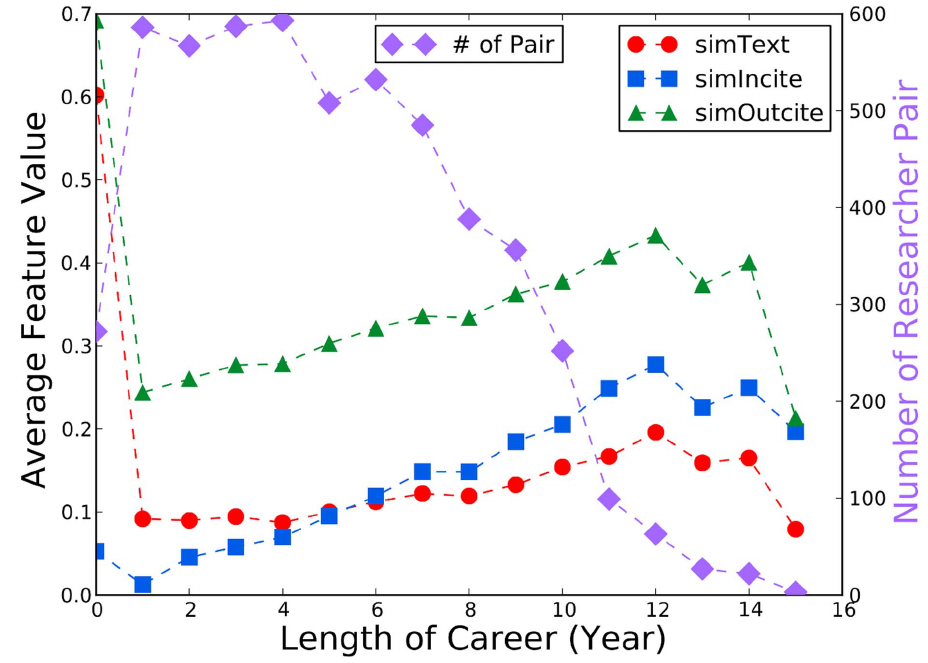
Figure 4. Research interest similarities over researcher career span. In the early stages of a researcher’s career, collaborators with less research similarity are found but collaboration between two experienced researchers shows greater research interest similarity.